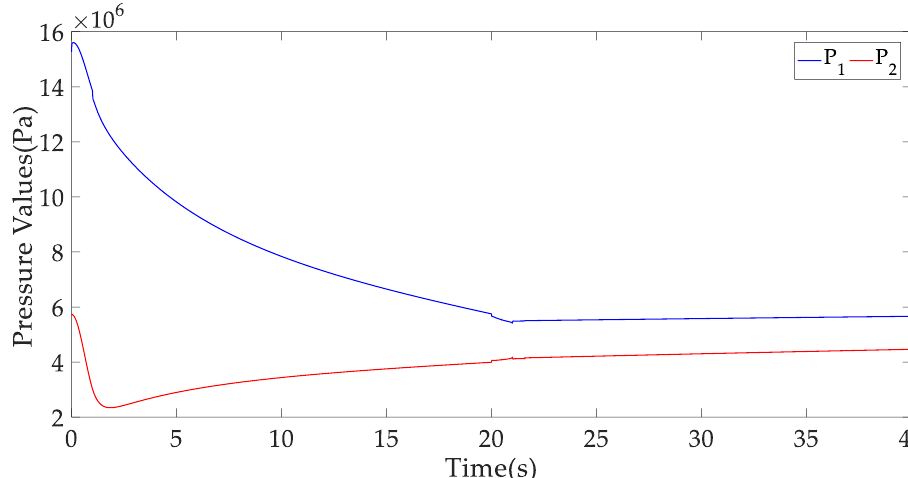
Figure 5. The control input in NRC.